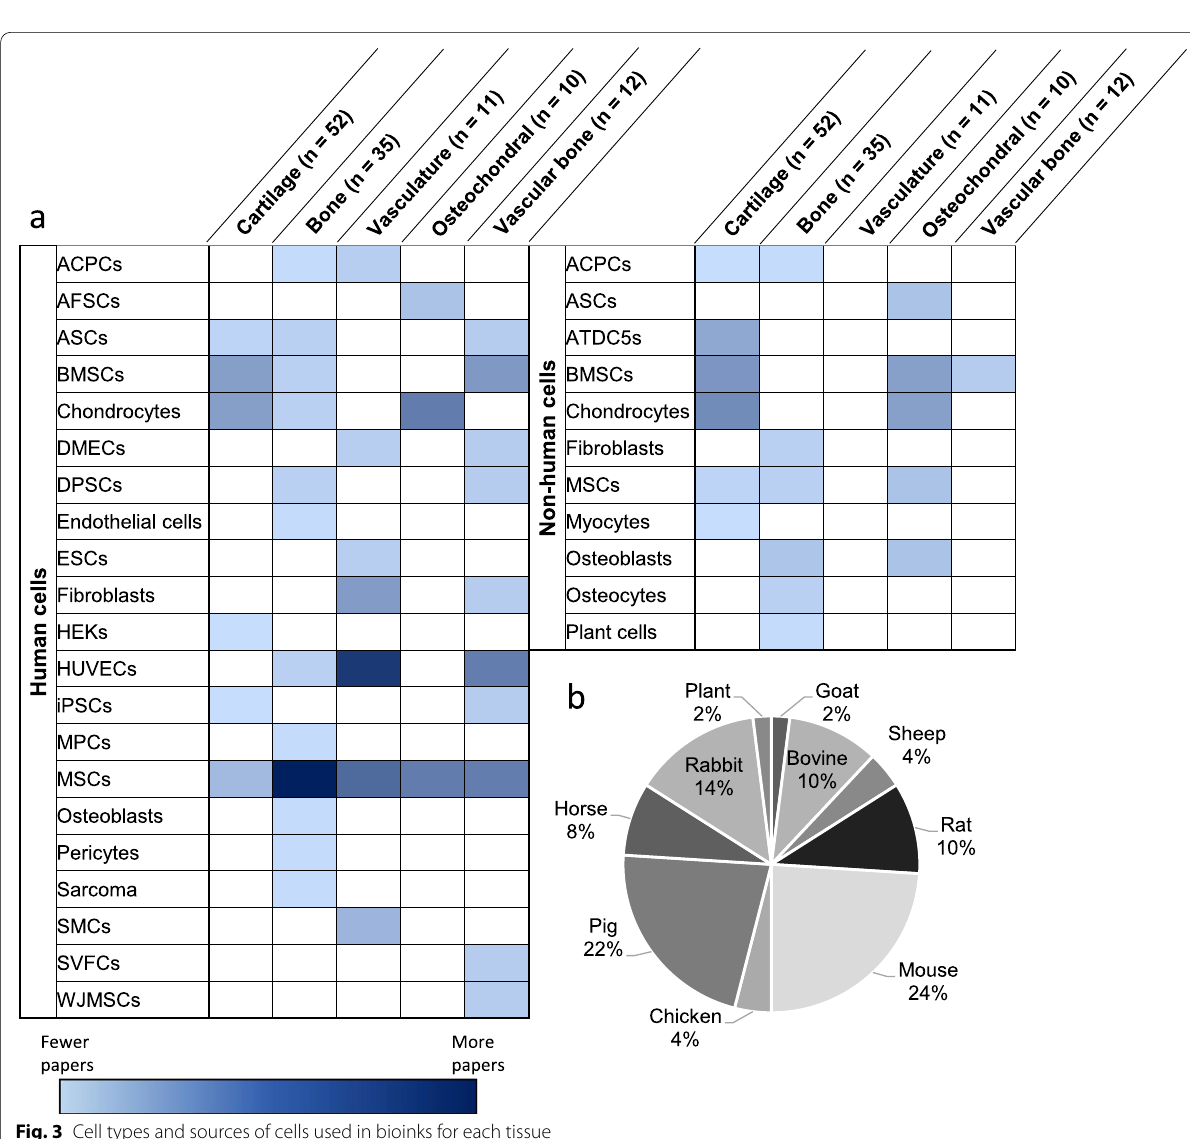
Fig. 3 Cell types and sources of cells used in bioinks for each tissue a ) Cells and derivation. b ) Non‑human cell sources. ACPCs: articular cartilage‑resident chondroprogenitor cells, AFSCs: amniotic fluid‑derived stem cells, ASCs: adipose‑derived stem cells, ATDC5s: mouse teratocarcinoma cell line, BMSCs: bone marrow stromal cells, DMECs: dermal microvascular endothelial cells, DPSCs: dental pulp stem cells, ESCs: embryonic stem cells, HEKs: human embryonic kidney cells, HUVECs: human umbilical vein endothelial cells, iPSCs: induced pluripotent stem cells, MPCs: mesenchymal progenitor cells, MSCs: mesenchymal stromal cells, SMCs: smooth muscle cells, SVFCs: stromal vascular fraction cells of adipose tissue, WJMSCs: Wharton’s jelly mesenchymal stromal cells. White indicates not